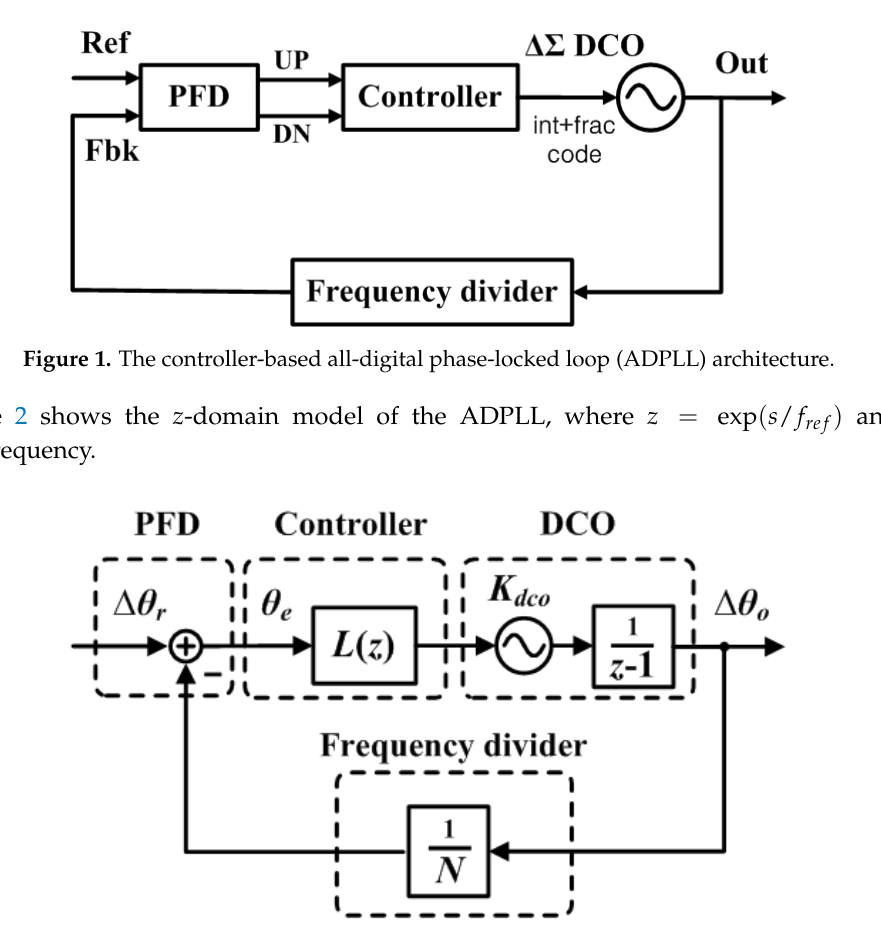
Figure 2. z -domain model of the controller-based ADPLL architecture. phase-frequency detector (PFD) gain ( K pfd ) and a scaling factor ( B scale ), which are used in Equation (3), are not shown for